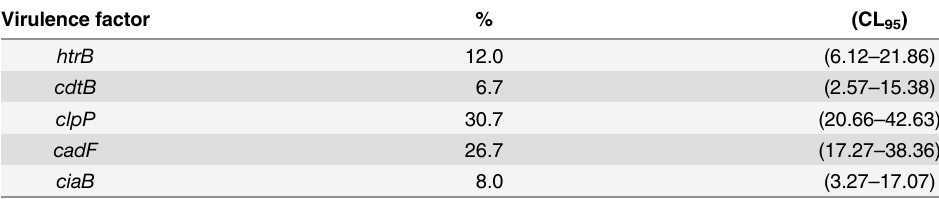
Table 4. Presence (%) of 5 virulence factors in DNA samples from BPW enrichment media of chickens that failed to produce colonies in Karmali